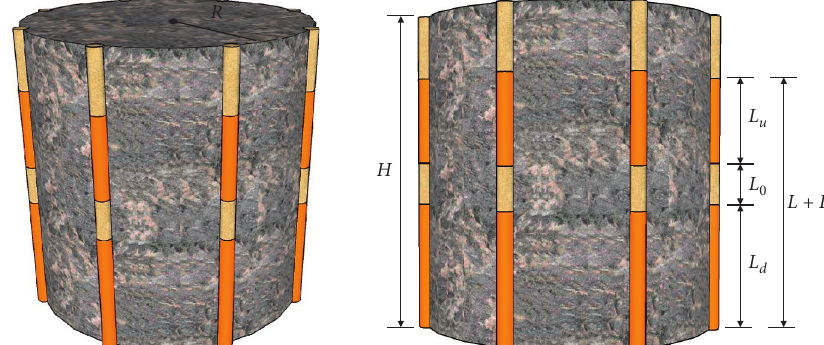
Figure 4: Schematic diagram of the two-step cut blasting